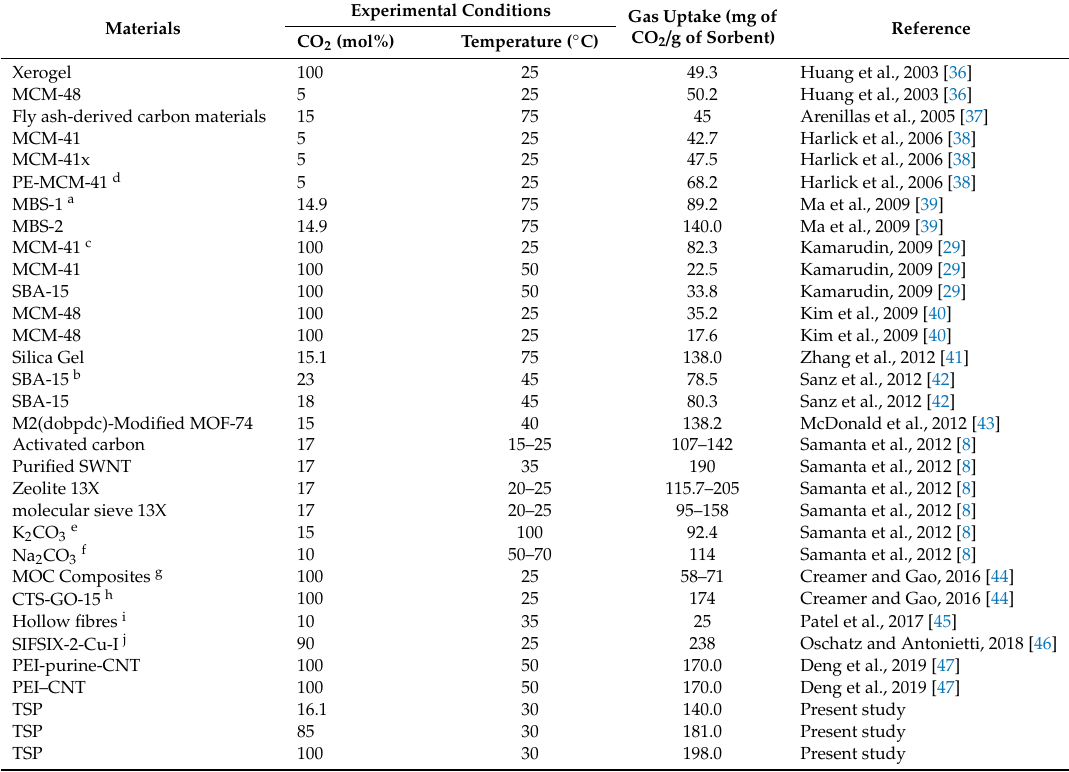
Table 3. Comparison of results obtained in this study and those reported earlier in the literature, along with experimental conditions.